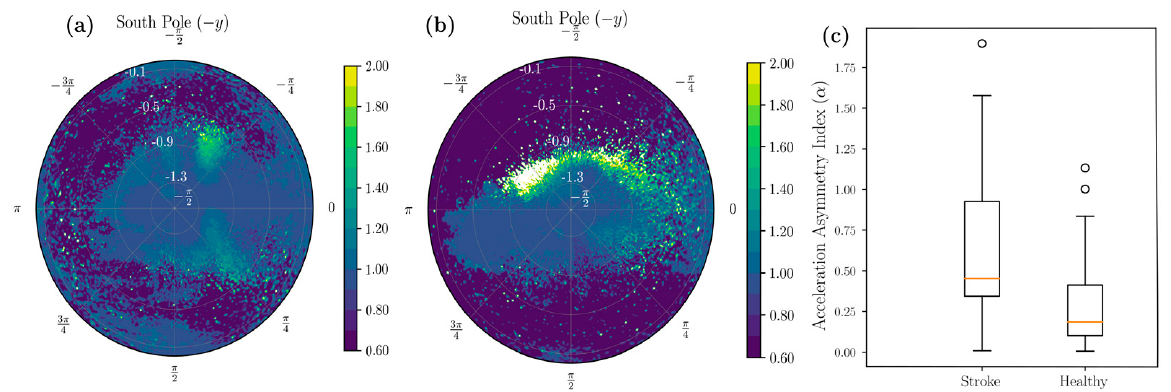
Figure 5. Visual comparison of symmetry in stroke versus healthy participants. ( a ) Distributions of mean accelerations in a healthy participant. ( b ) Distribution of means in a stroke participant. ( c ) Box plot representing acceleration asymmetry index (AAI) and stroke and healthy individuals.